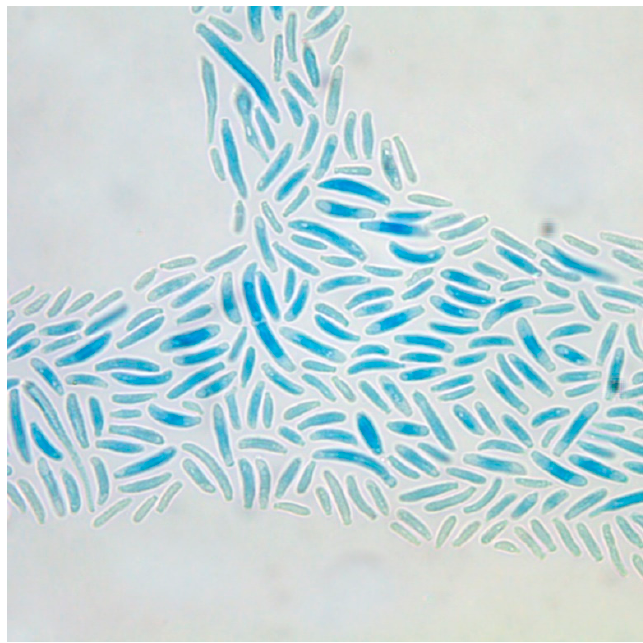
Figure 1. Micromorphological characteristics of Fusarium spp.: curved macroconidia of Fusarium oxysporum. (Magnification 400 × ).